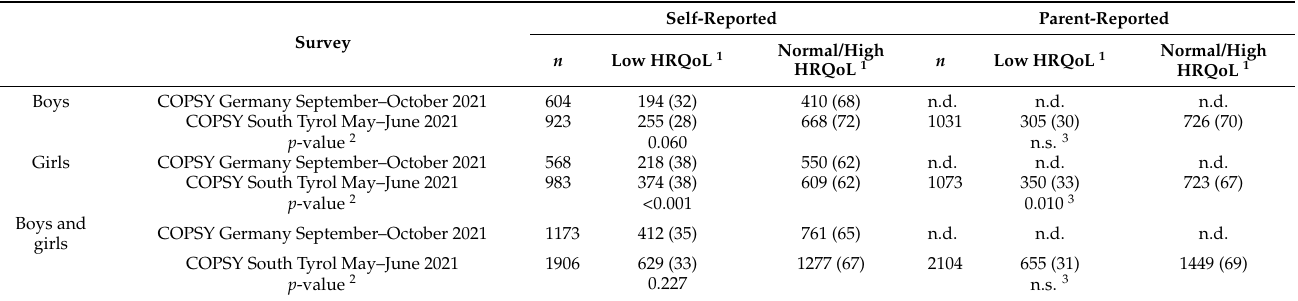
Table 2. HRQoL in children and adolescents during the COVID-19 pandemic, stratified by gen- der (self-report, 11–17 years COPSY Germany [third wave longitudinal study] 2021; self-report, 11–19 years COPSY South Tyrol